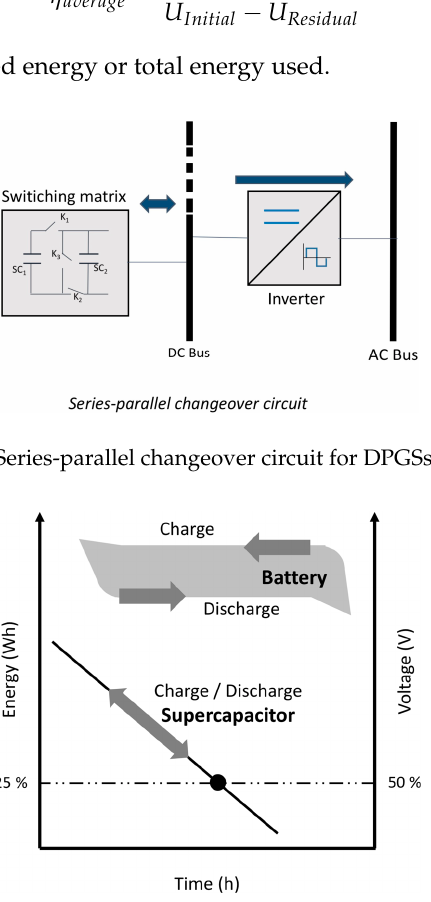
Figure 3. Supercapacitor charge/discharge curve.